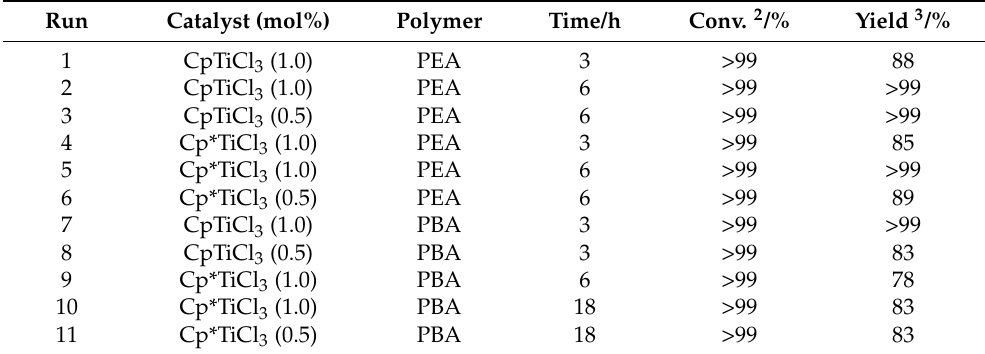
Table 1. Depolymerization (transesterification) of poly(ethylene adipate) (PEA), poly(butylene